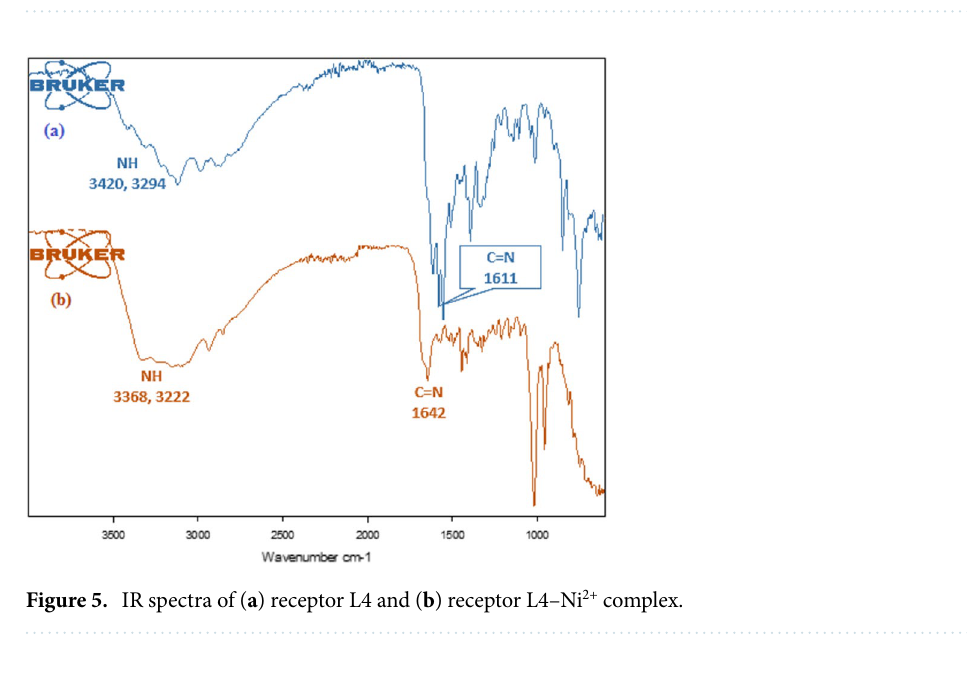
Figure 4. Naked eye detection limit for receptor L4.